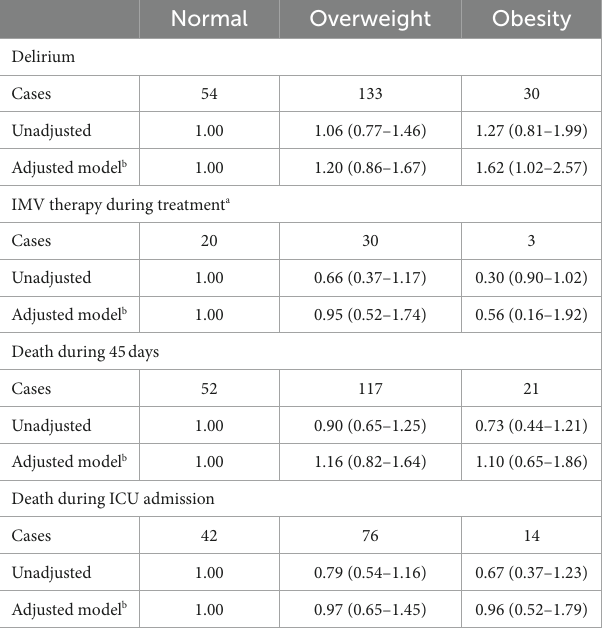
TABLE 3 Hazard ratios for some outcomes of critically ill elderly patients with COVID-19 across categories of BMI.